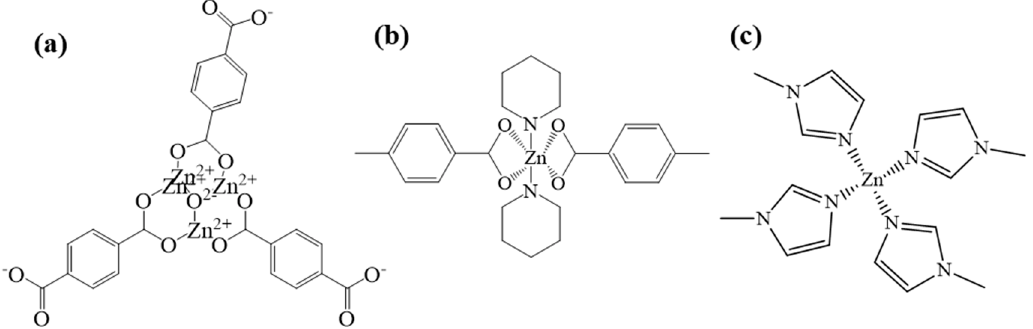
Figure 2. Schematic diagram of chemical structures for MOF5 ( a ), TEDA-PD ( b ), and ZIF8 ( c ).